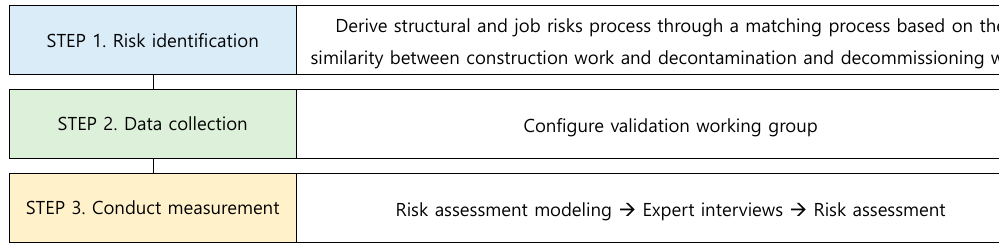
Figure 1. Flow of research methodology.